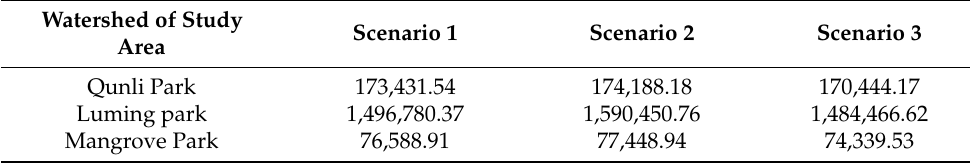
Table 6. Runoff model of urban flood export (Unit: m 3